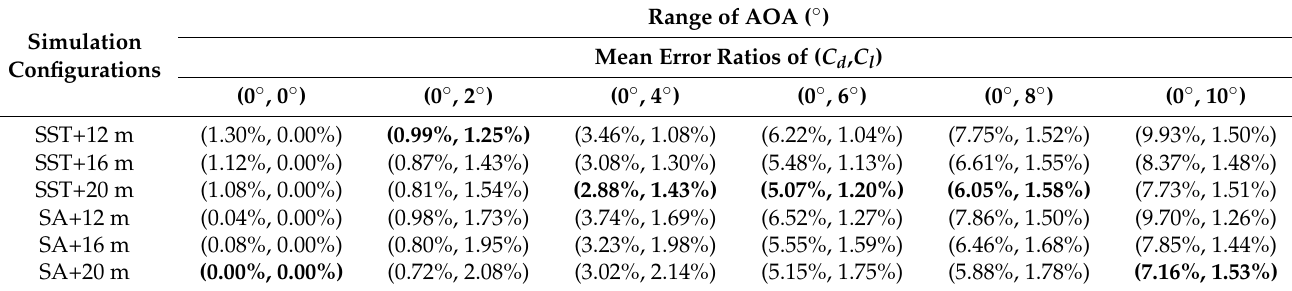
Table 11. The mean error ratios of C d and C l of the sharp trailing edge based on definition formula applying 200 points.